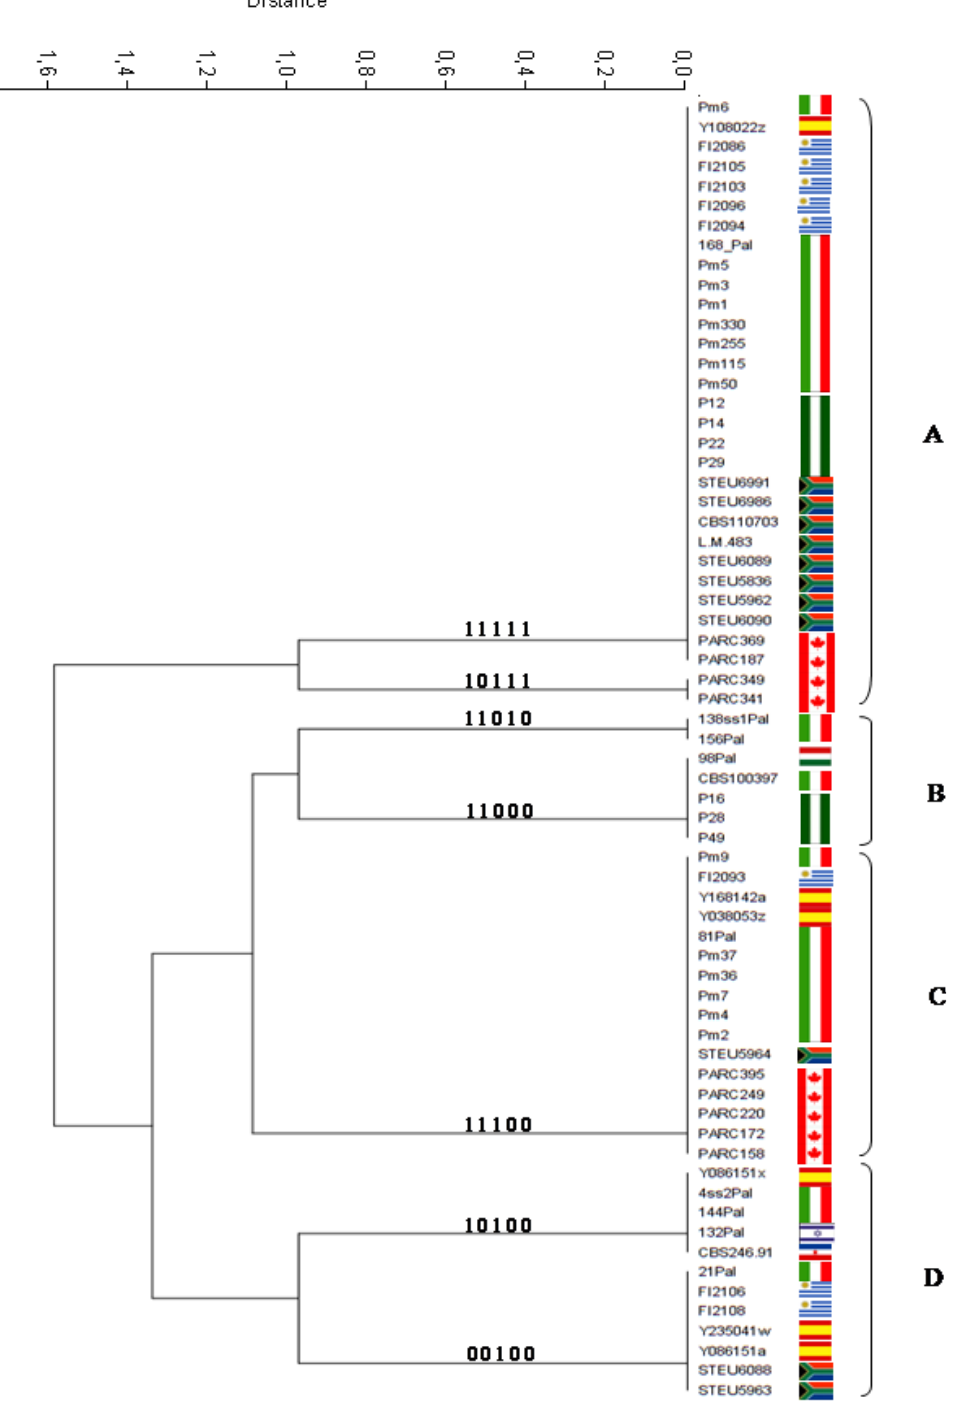
Figure 1. Cluster analysis showing haplotype grouping of isolates of Togninia minima . Haplotype codes are shown upon terminal branches. Country of origin of each sample is indicated